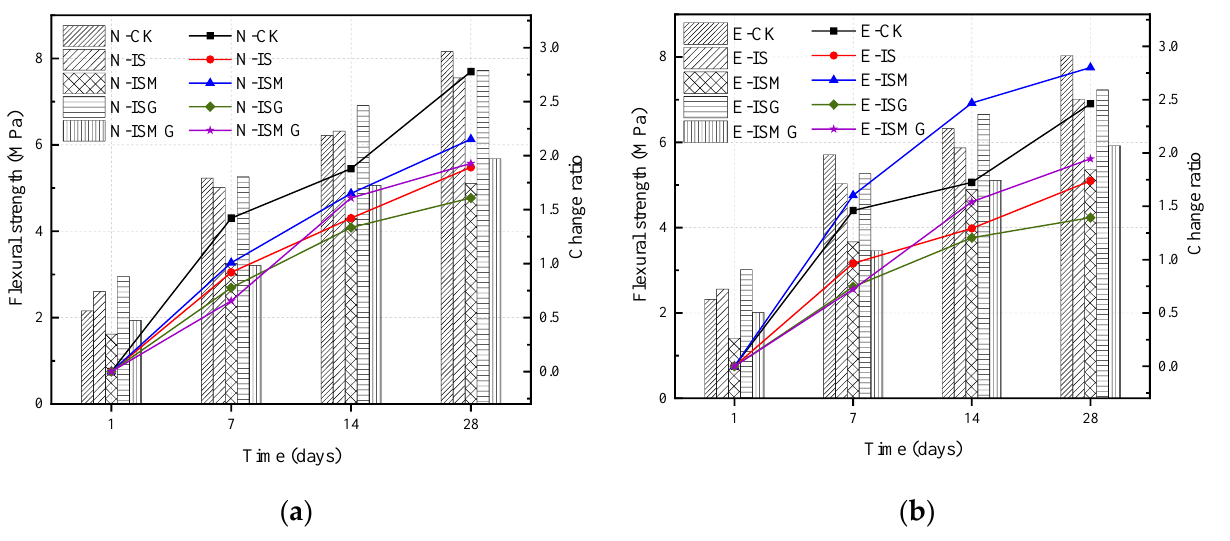
Figure 3. Flexural strength and change ratio of specimens in different stages: ( a ) NC specimens and ( b ) EC specimens.